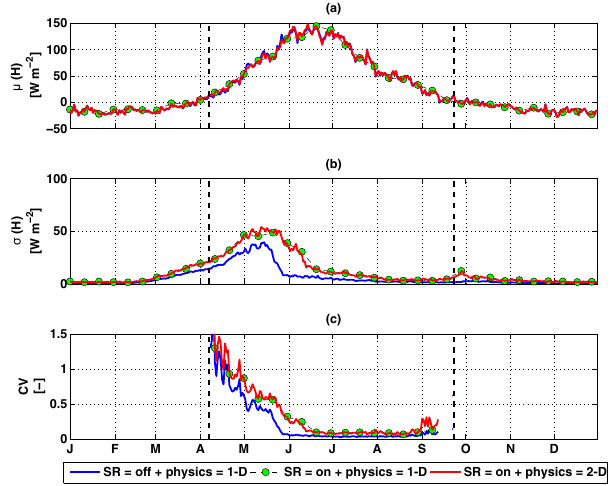
Figure 11. Same as Fig. 10 except for sensible heat flux.